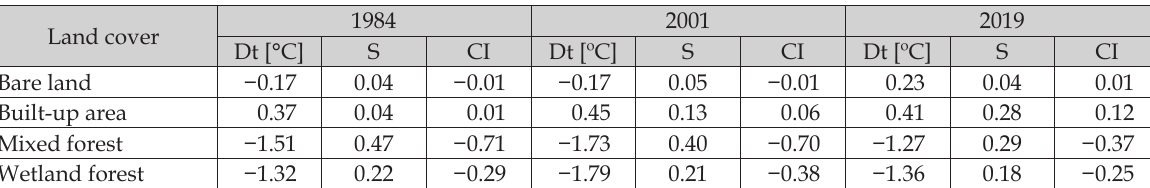
Fig. 8. Mean LSTs associated with the different land cover classes. Table 4. Contribution index (CI) for 1984, 2001 and